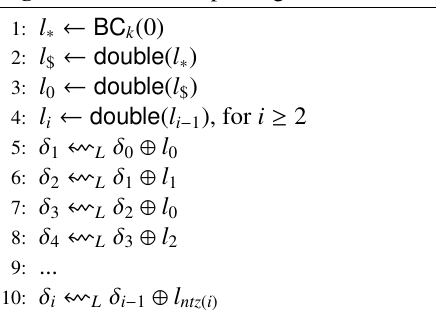
Algorithm 2 O ff set updating for